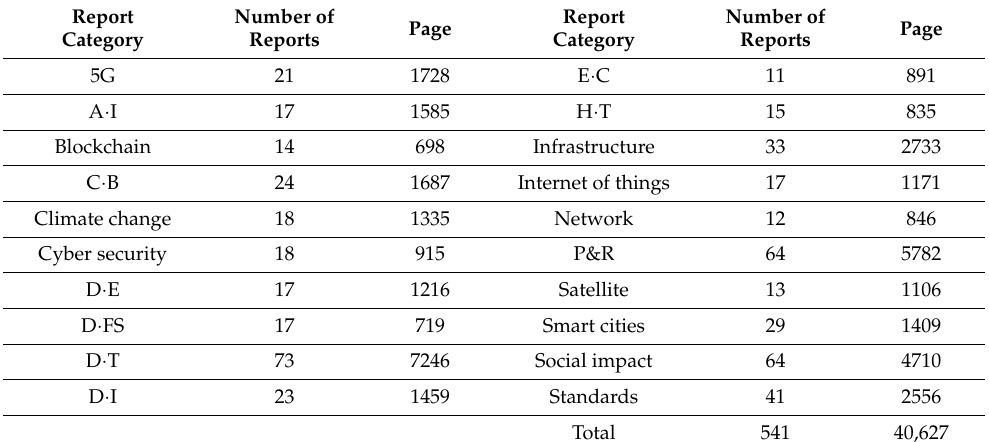
Table 1. List of Selected Reports (http://www.itu.int/hub?s=&post_type=publication, accessed on 31 December